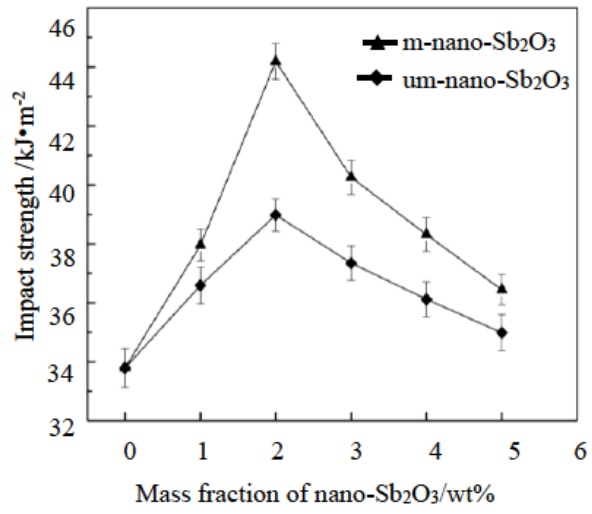
Figure 5: Relationship between impact strength of the experimental materials and mass fraction of nano-Sb 2 O 3 particles